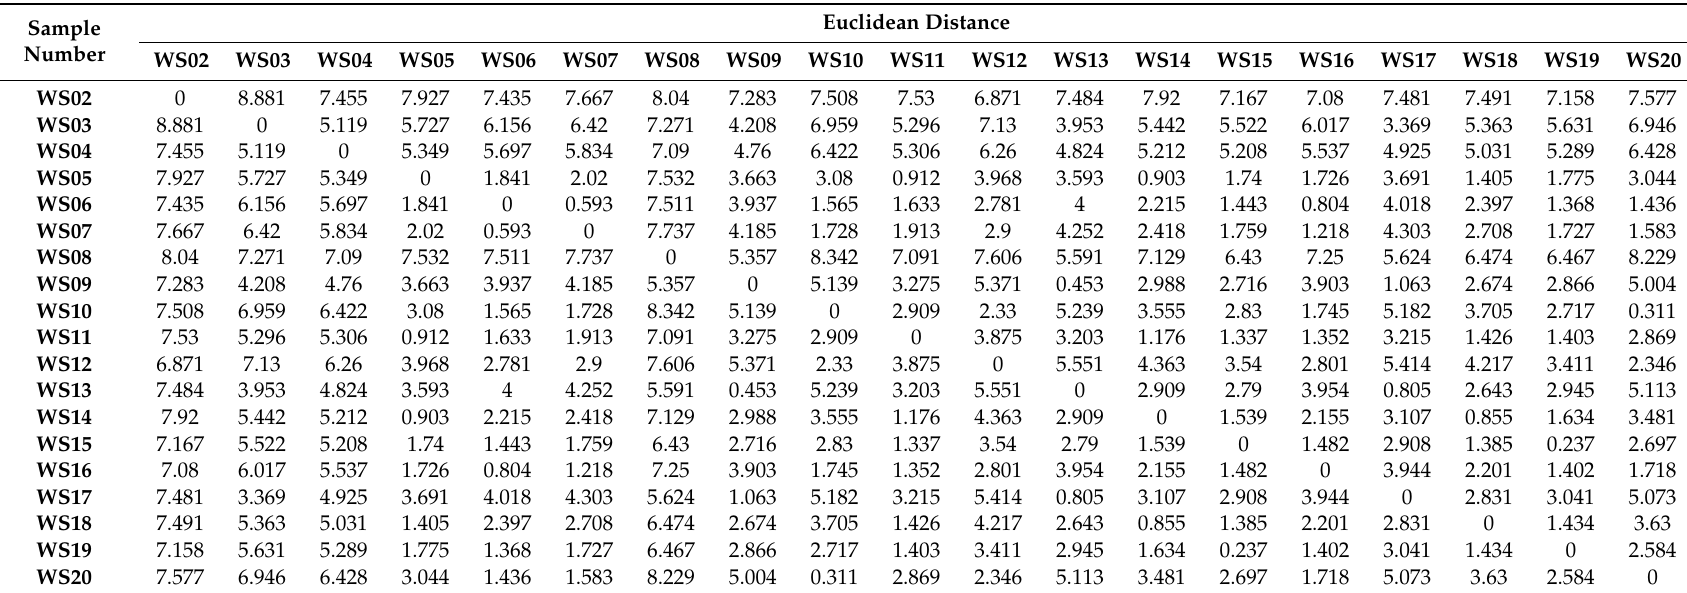
Table 3. Euclidean distance matrix of water